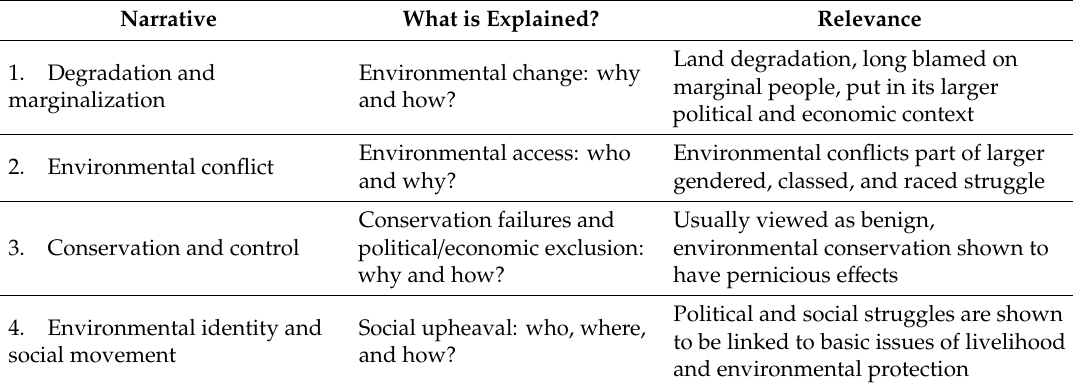
Table 1. Dominant narratives in political ecology. Redrawn from Robbins (2004)